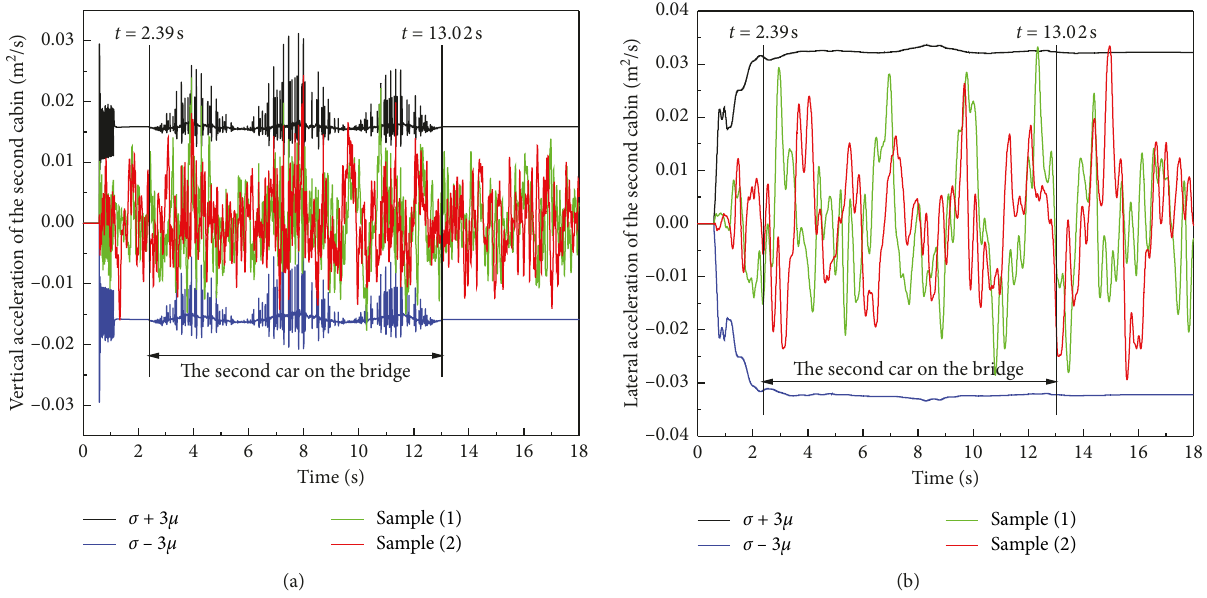
Figure 7: Comparison of time histories of the cabin acceleration between the estimated boundary and the conventional calculation for (a) vertical and (b) lateral directions.